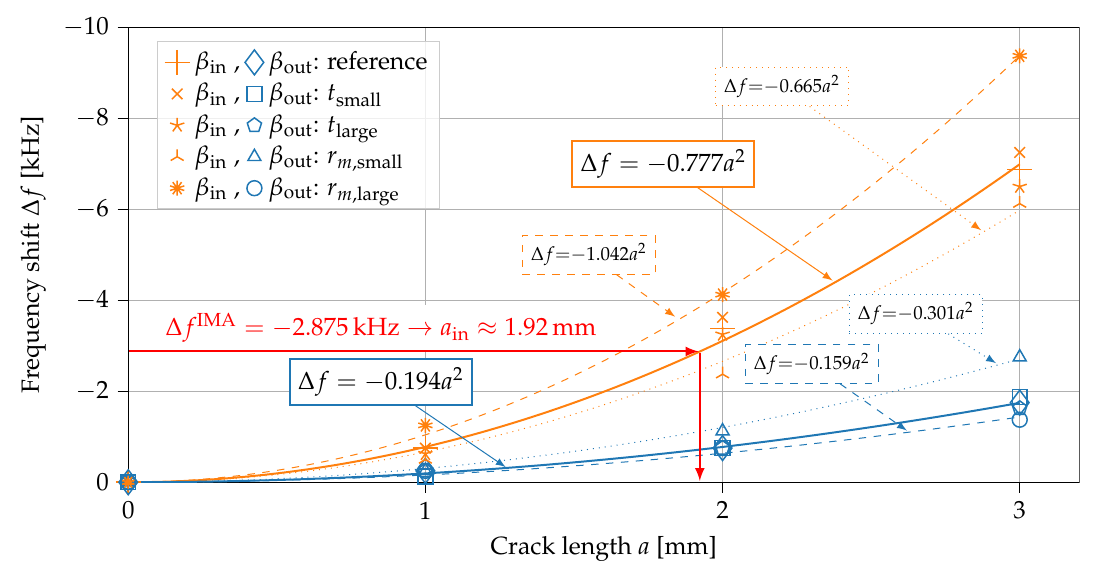
Figure 12. Shift of resonance peaks ∆ f due to growing cracks at β in = 90° and β out = 145° in necked lugs with different geometries according to Table